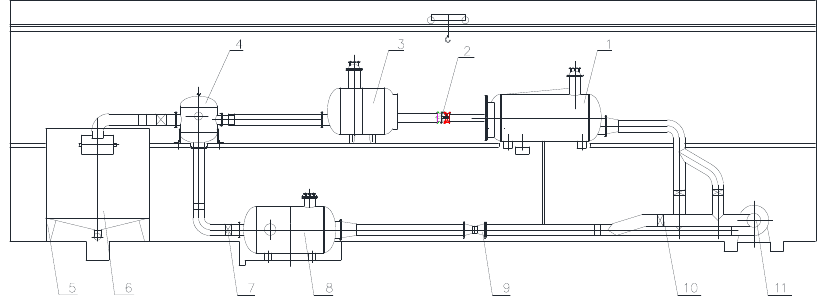
Figure 3. High-precision plan of the hydraulic mechanical test bench. 1. Inlet tank, 2. Test pump, 3. Pressure outlet tank, 4. Bifurcation tank, 5–6. Flow rate in-situ calibration device, 7. Working condition regulating gate valve, 8. Pressure regulating rectifier, 9. Electromagnetic flow meter, 10. Operating control gate valve, and 11. Auxiliary pump unit .